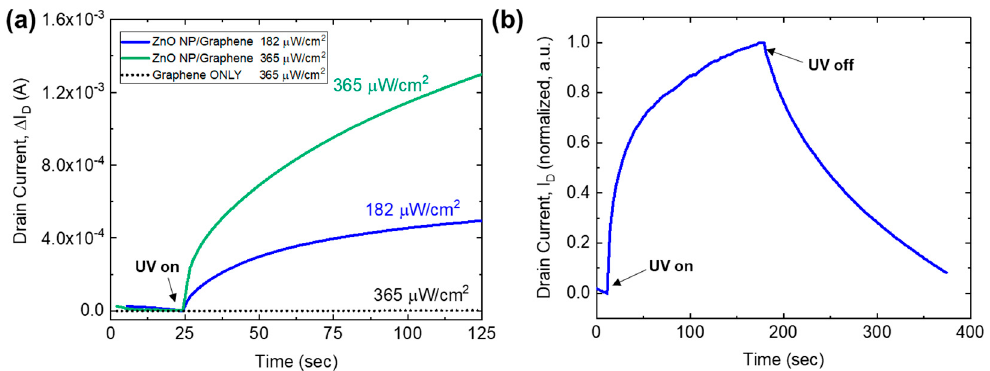
Figure 8. Temporal photoresponse of ZnO nanoparticle/graphene devices: ( a ) ZnO nanoparticle/graphene device compared with the graphene only device at 182 µW/cm 2 and 365 µW/cm 2 ; ( b ) optical intensity of 182 µW/cm 2 showing the rise and fall as intensity is turned both on and off, respectively.